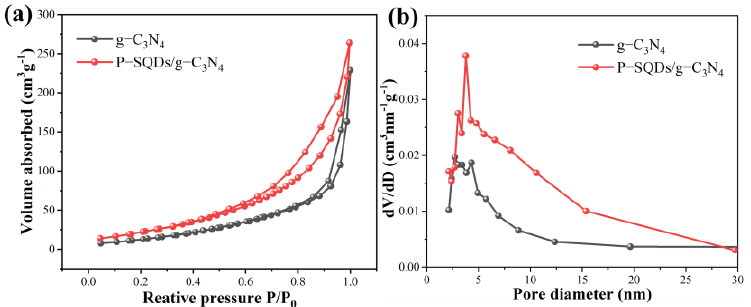
Figure 2. ( a ) N 2 adsorption – desorption isotherms and ( b ) pore size distribution curves of g-C 3 N 4 and P-SQDs/g-C 3 N 4